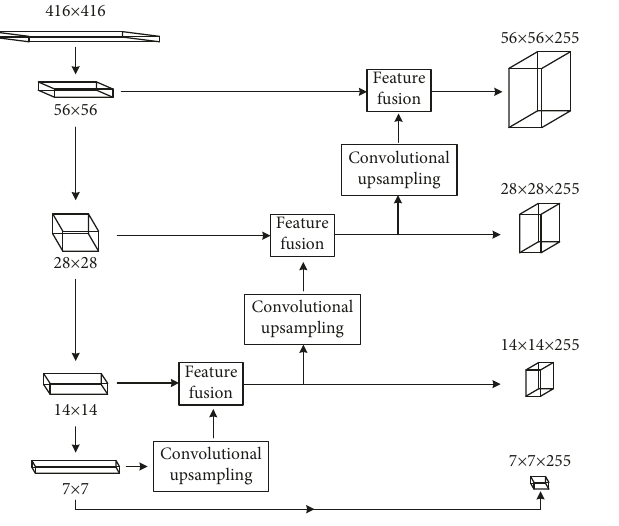
Figure 5: The basic structure of the improved YOLOv3.